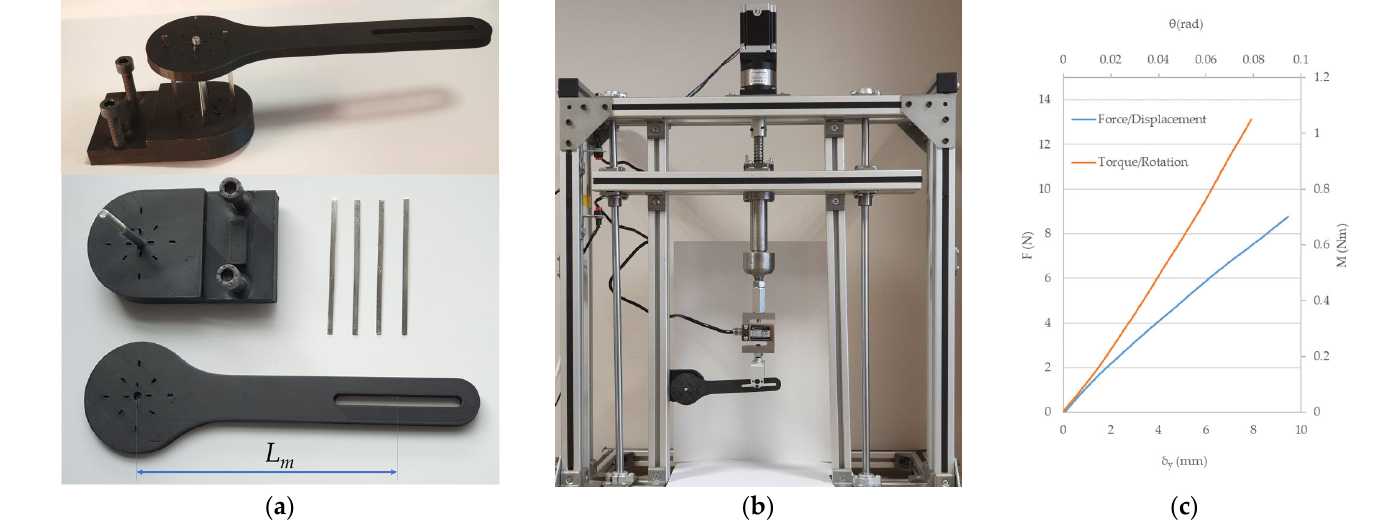
Figure 3. ( a ) Experimental fixture, ( b ) test setup, and ( c ) representative curves of F- δ y and M- θ . ( F , pull or push force of the device; M , moment forcing the elastic joint; θ , Flexion angle of the elastic joint; δ y , vertical displacement of the force application point). M = FL m and θ = tan − 1 (cid:3435)𝛿 (cid:3052) 𝐿 (cid:3040) ⁄ (cid:3439) .